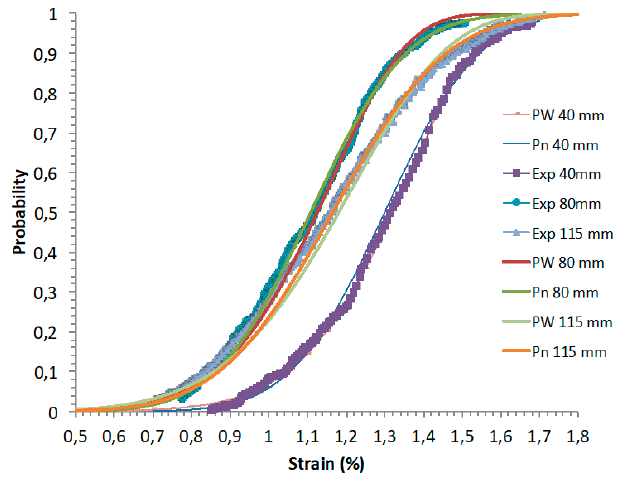
Figure 5. Experimental cumulative distributions derived from the force–strain curves and normal (Pn) and Weibull (PW) distribution functions derived from the p-quantile diagrams of Figure 4.